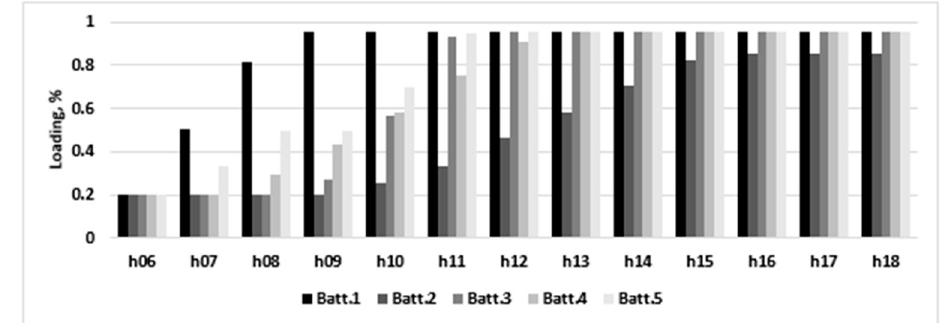
Figure 13. The charge pattern for the batteries, Scenario 3.